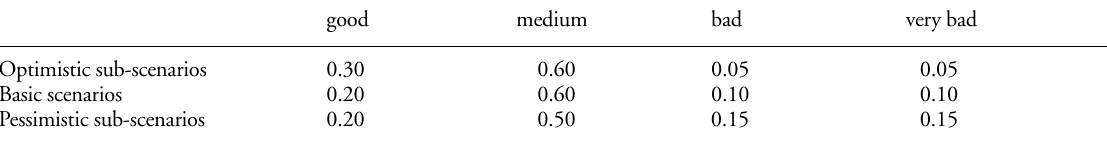
Sex ratio of newborns m/f : 1.3 Probabilities for environmental conditions influencing survival rates